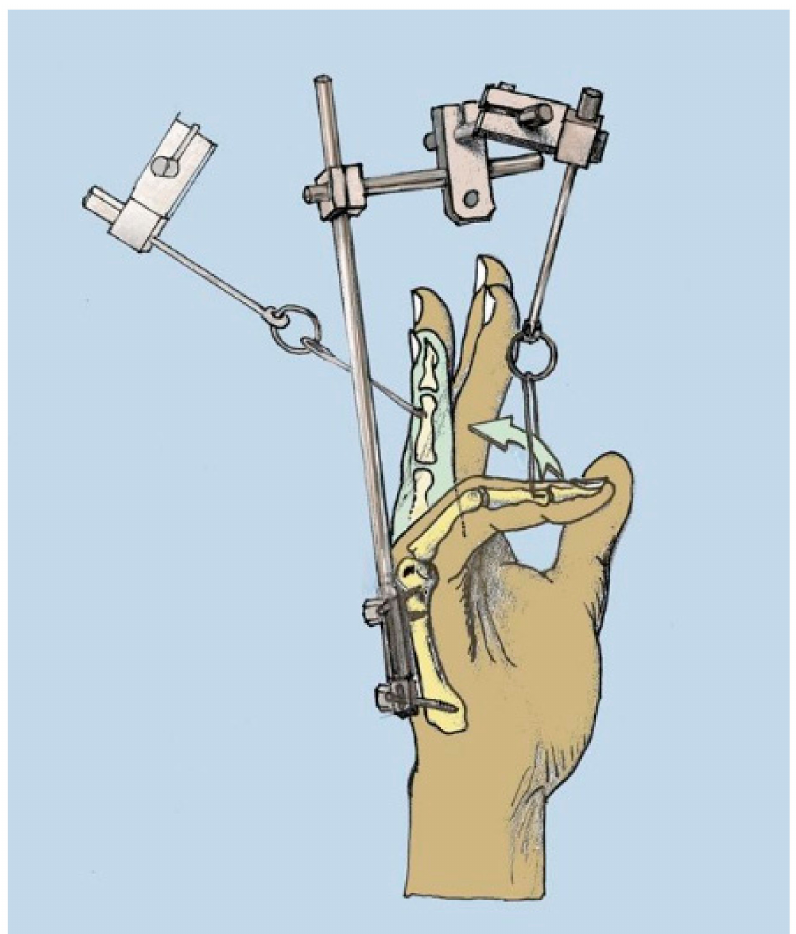
Figure 1. Schematic depiction of Messina’s skeletal distraction device, modified from Brenner P, Ray Ghazi M. (ed.) Morbus Dupuytren: Ein chirurgisches Therapiekonzept, Springer Verlag Berlin- Heidelberg-New York, 2003, ISBN 978-3-7091-6723-6 (copyright R E